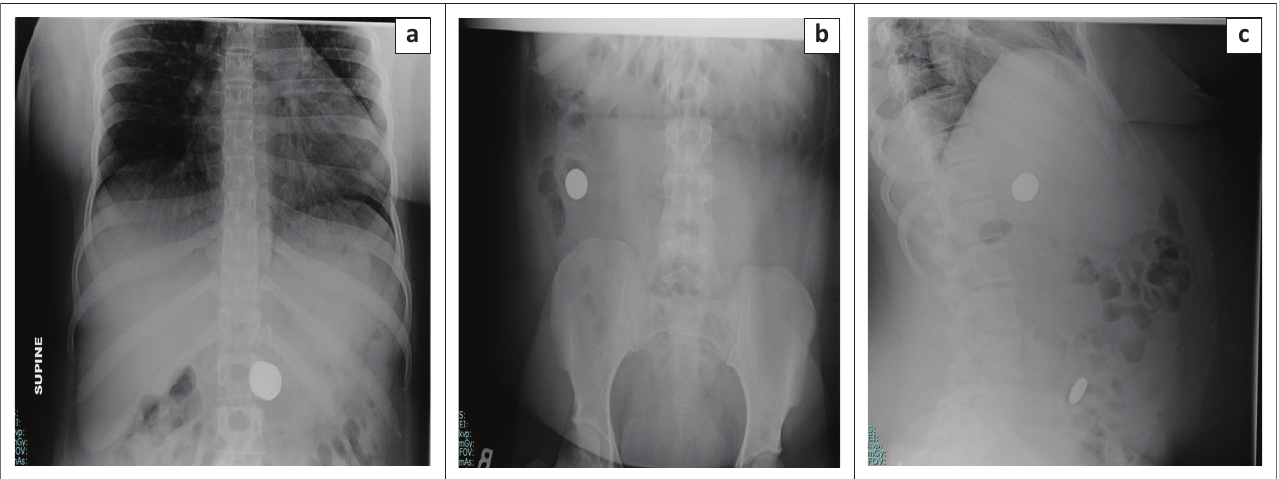
FIGURE 4: Serial abdominal radiographs frontal (a and b) and lateral (c) views of a 16-year-old female patient with a psychiatric history who presented with multiple coin ingestions and was managed